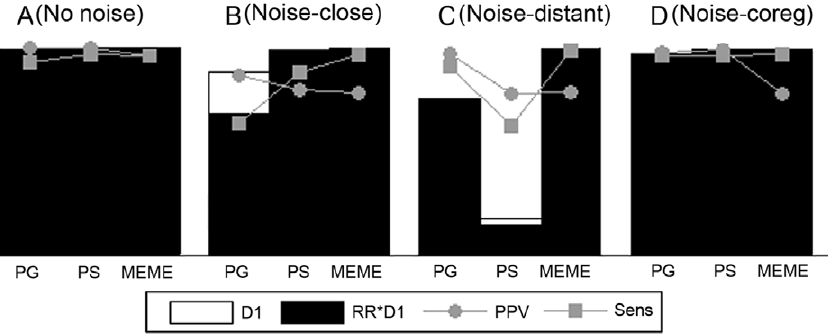
Figure 5. Effect of motif loss on motif detection in the combined space. The results are displayed for a synthetic dataset containing sites sampled from a high IC motif. Each dataset consists of ten coregulated reference genes complemented with their orthologs, also referred to as ten orthologous sets. Each orthologous set consists of five prealigned sequences related through an unequal star topology: four closely related orthologs with proximities of respectively 0.80 (reference ortholog), 0.90, 0.85 and 0.75 and one distantly related ortholog with a proximity of 0.20. Panel (A) represents the results when a motif site is present in all sequences of the orthologous sets. Panels (B) and (C) display the results when motif loss occurs in all sequences derived from respectively a closely (q=0.75) or a distantly (q=0.20) related species. Panel (D) shows the results when motif loss occurs in two out of ten coregulated reference genes and in all their corresponding orthologs. For the measures D1, RR*D1, PPV and Sens see Figure